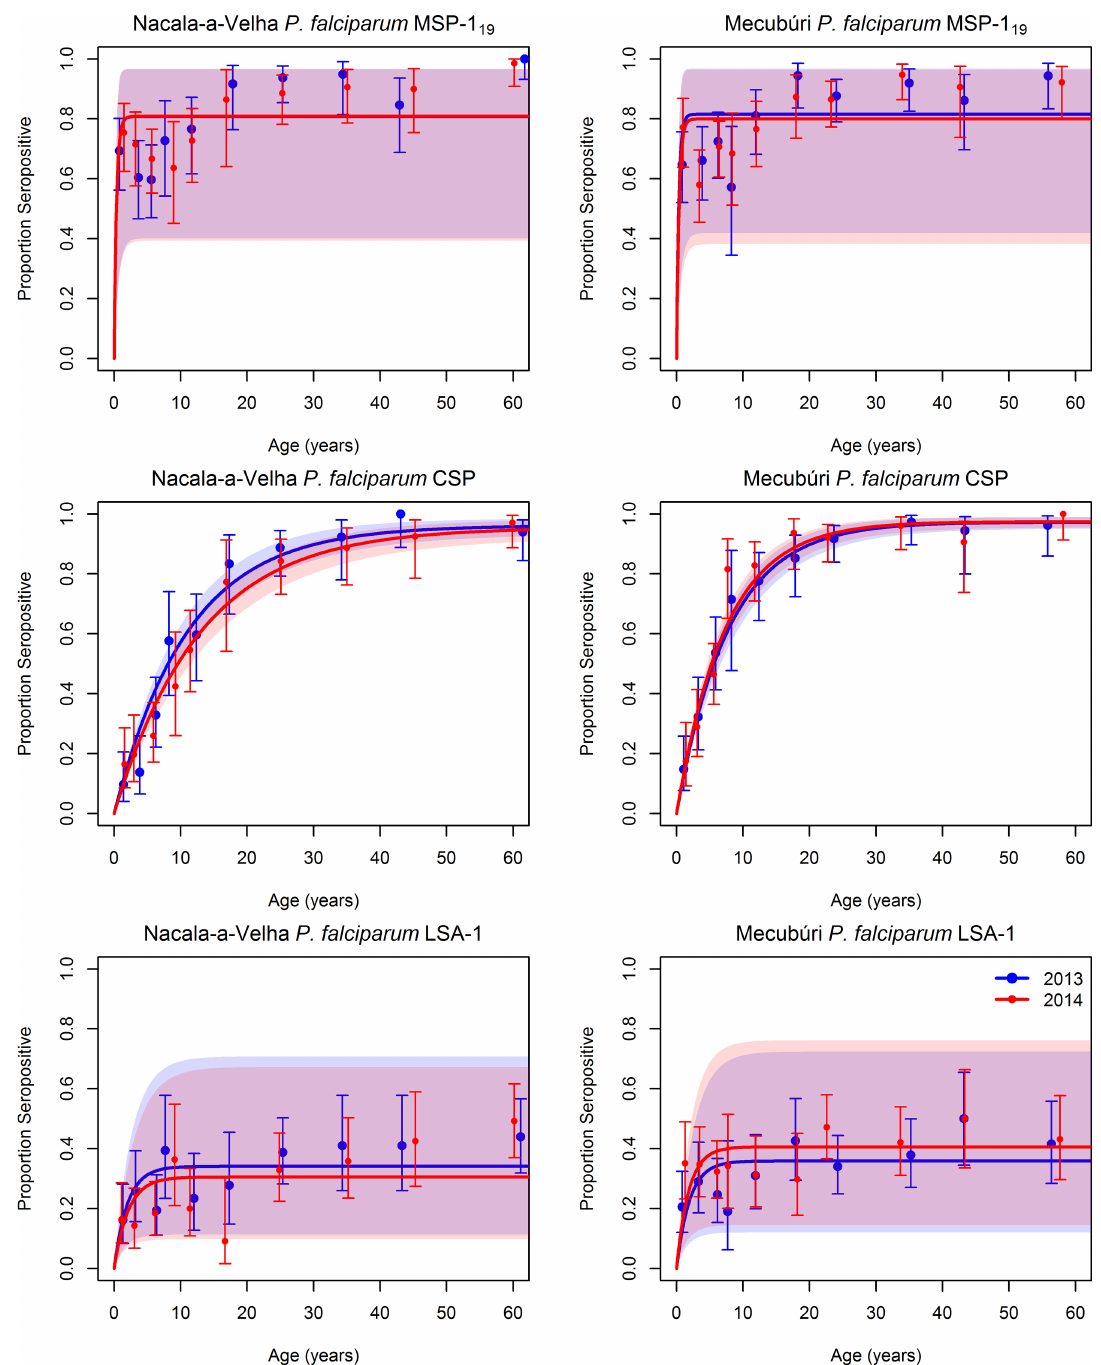
Fig 1. Seropositivity by age for antibodies to three P . falciparum antigens in community members sampled during household surveys in Nacala-a-Velha and Mecubu´ri Districts, Northern Mozambique, 2013–2014. Points represent estimates and 95% confidence intervals for seropositivity for each age category, curves represent the fit of a catalytic conversion model, and shaded areas represent the 95% confidence intervals of model fit: blue for 2013, red for 2014, and purple for the overlap.